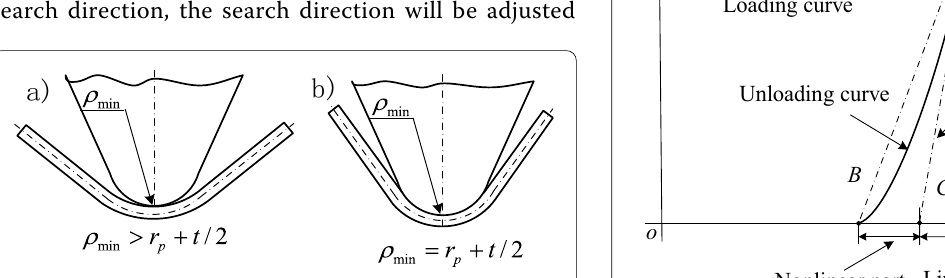
Figure 3 Contact state during forming: a No contact the punch; b Contact the punch